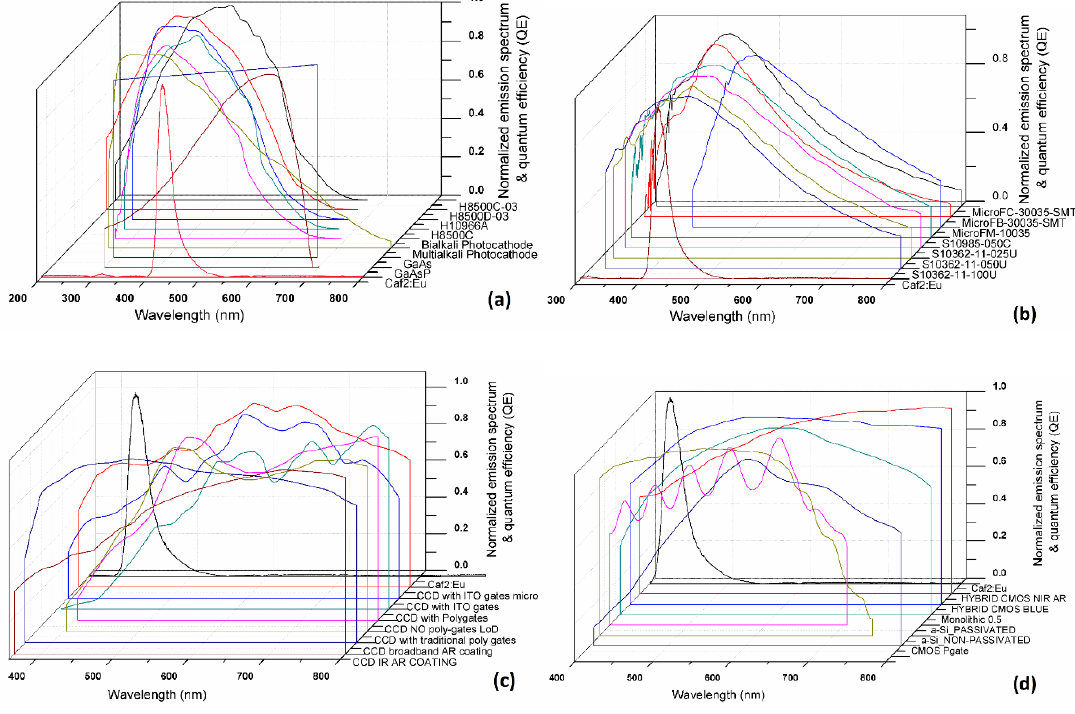
Figure 2. CaF 2 :Eu single crystal emitted spectrum along with the sensitivity of: ( a ) and ( b ) photomultiplier tube (PMTs) and photocathodes, ( c ) charge-coupled devices (CCDs), ( d ) complementary metal–oxide semiconductor (CMOS) sensors, and amorphous hydrogenated silicon photodiodes.